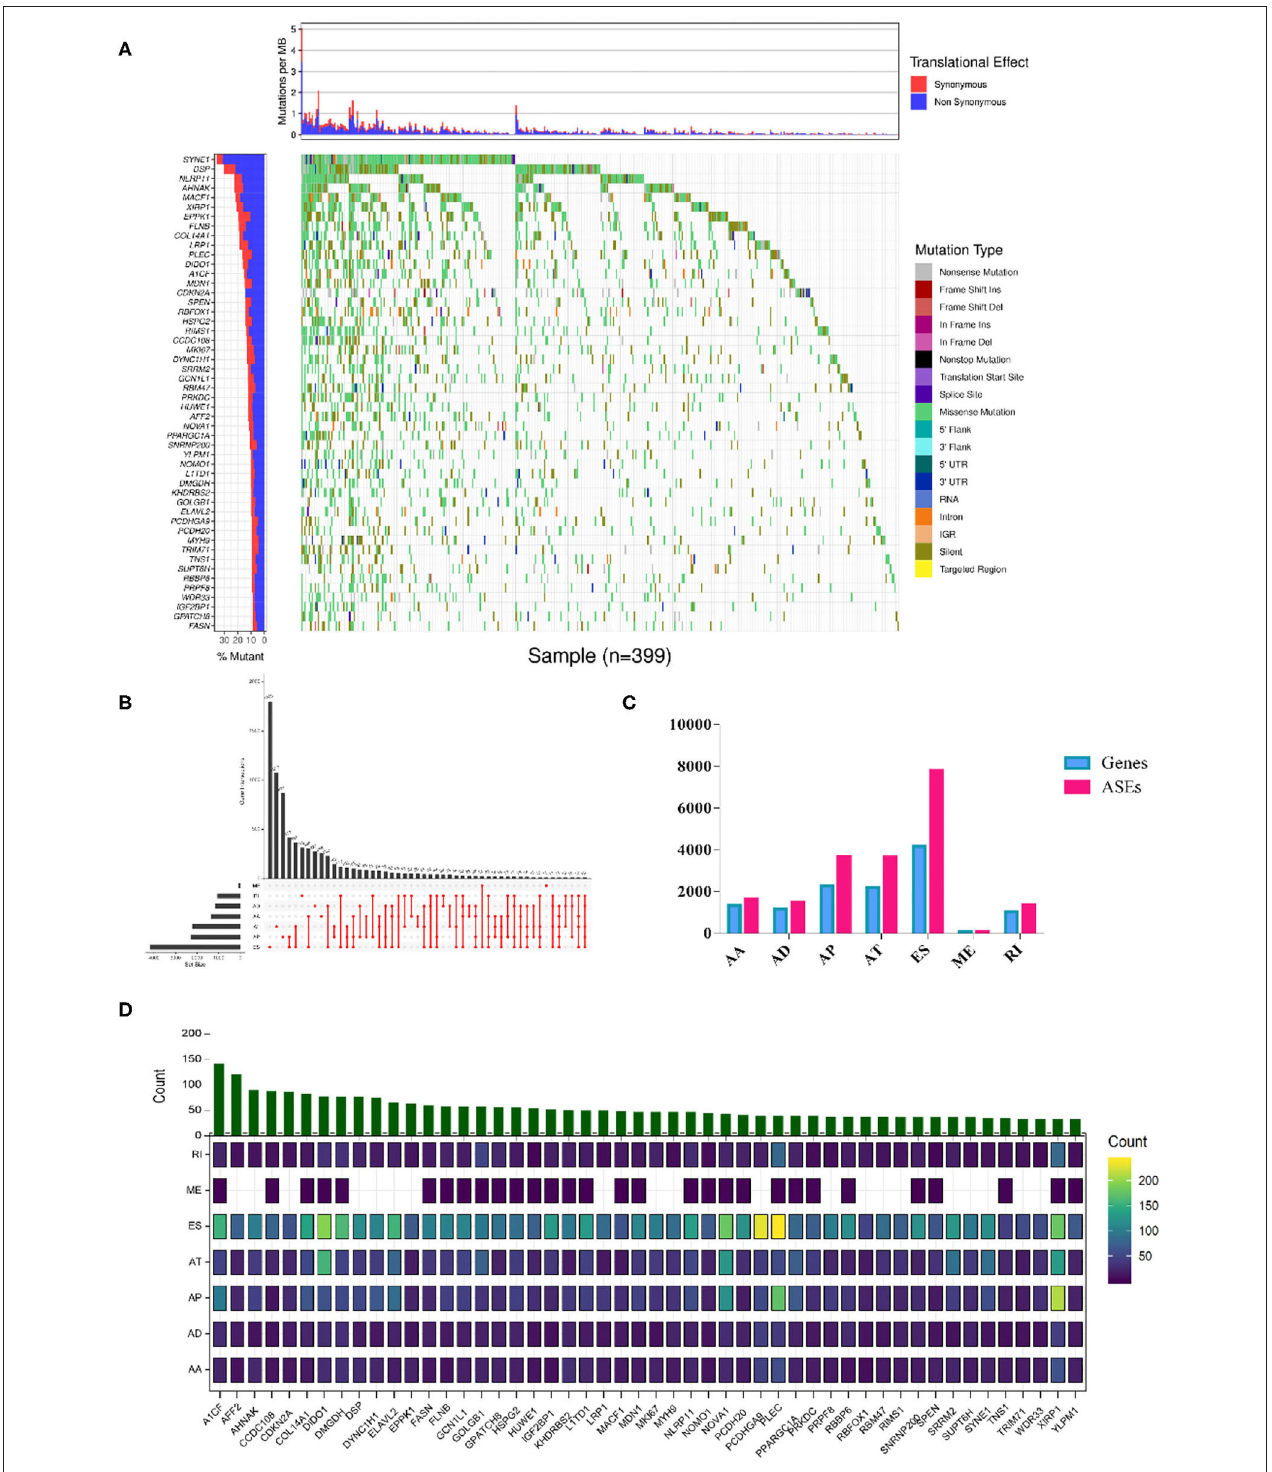
FIGURE 2 | RBP mutations triggered splicing event alterations. (A) Among the 853 RBPs whose mutations showed significant correlations with aberrant ASEs (Wilcoxon test P -values < 0.01). The mutation situations of the top 50 RBPs with the highest mutant frequency were exhibited. The y-axis represents each RBP and sorted by mutation frequency. The x-axis stands for different SKCM samples. The color indicates different mutation types. The bar plot above represents the mutation frequency with synonymous (red) and non-synonymous (blue) translational effects for each SKCM patient. (B) Upset plot of each splicing pattern affected by RBP